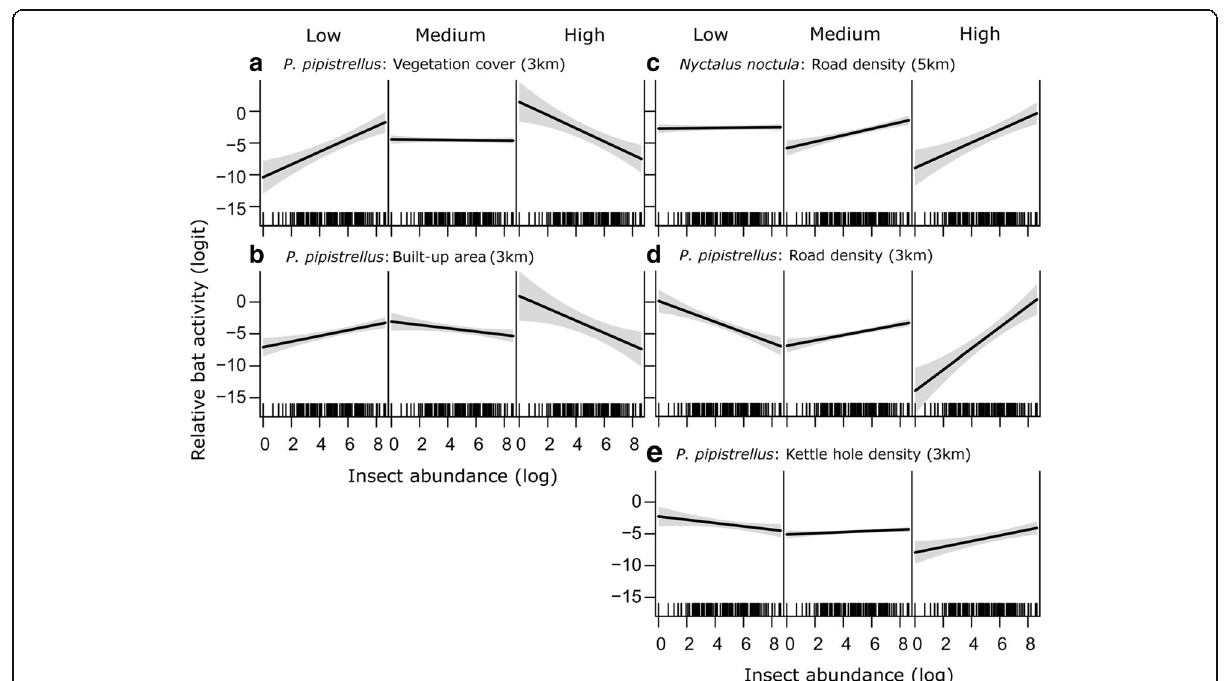
Fig. 3 Effect plots for interaction effects show how low, medium, and high values of landscape characteristics affect the relationship between relative bat activity and insect abundance above arable fields. The spatial scale at which landscape characteristics were relevant is given